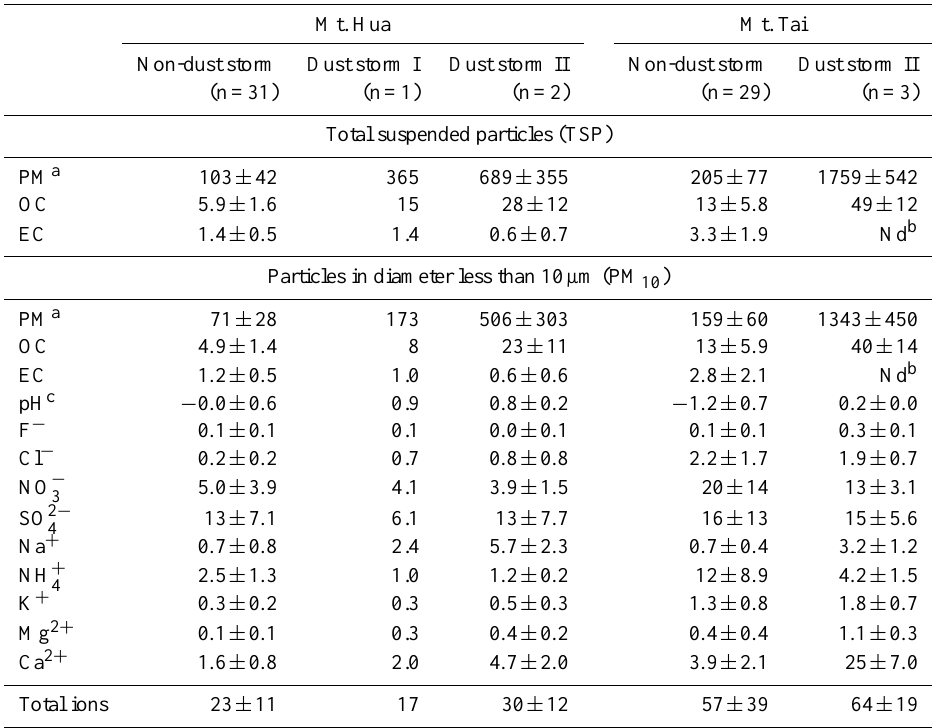
Table 2. Concentrations of OC, EC and inorganic ions in aerosols from the atmospheres of Mt. Hua and Mt. Tai in China during the spring of 2009,µgm − 3